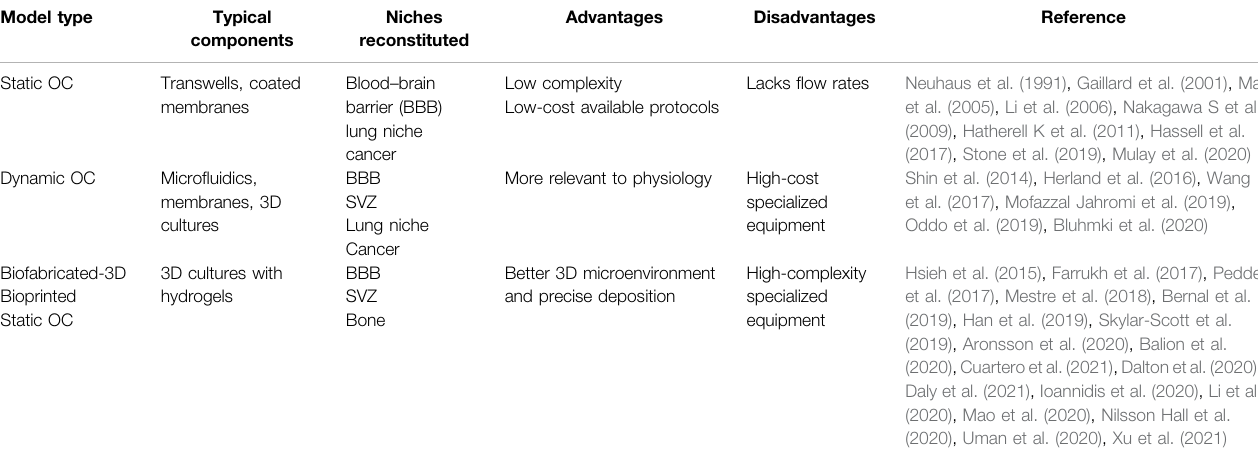
TABLE 1 | Summary of the different available protocols along with their advantages and disadvantages depending on their features and typical components. Model